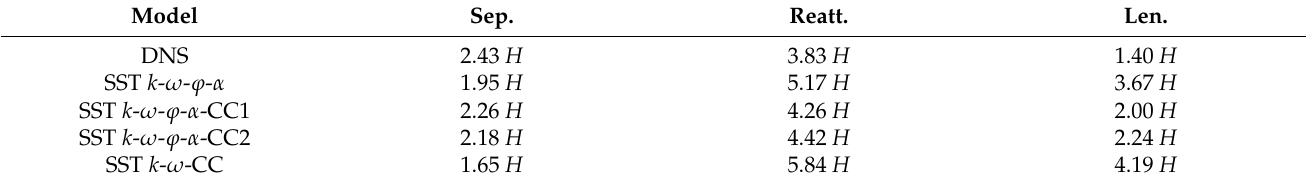
Table 1. The separation point (Sep.), re-attachment point (Reatt.), and the re-circulation length (Len.), in the 2D infinite serpentine passage